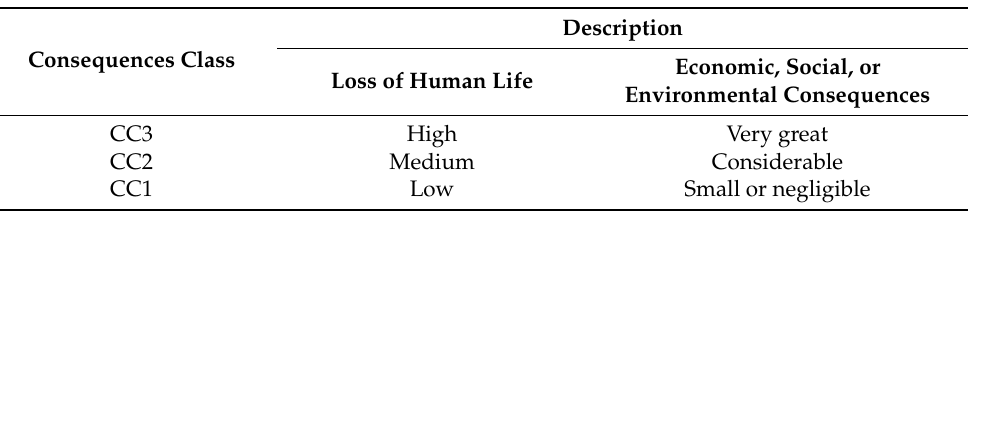
Table 1. Definition of consequences classes (modified from